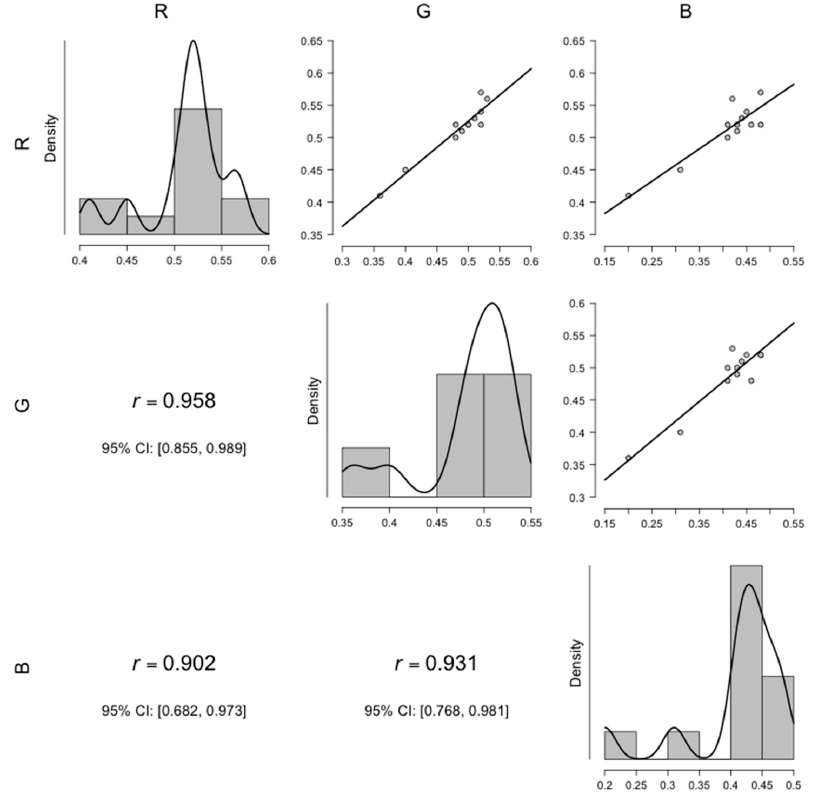
Figure 4. Pearson’s correlations between the RGB components. The diagonal charts show the intensity of the colors. CI = confidence interval; r = Pearson’s coefficient.